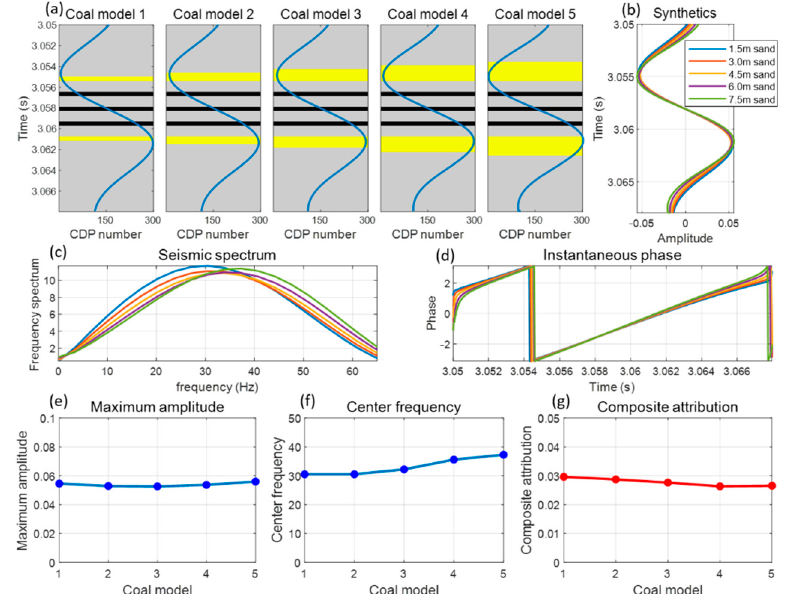
Figure 2. Model of thin coal seams coupled with sandstone and its synthetics and attributes: ( a ) coal model, ( b ) synthetic, ( c ) seismic frequency spectrum, ( d ) instantaneous phase, ( e ) maximum ampli- tude, ( f ) centre frequency, and ( g ) composite attribute.